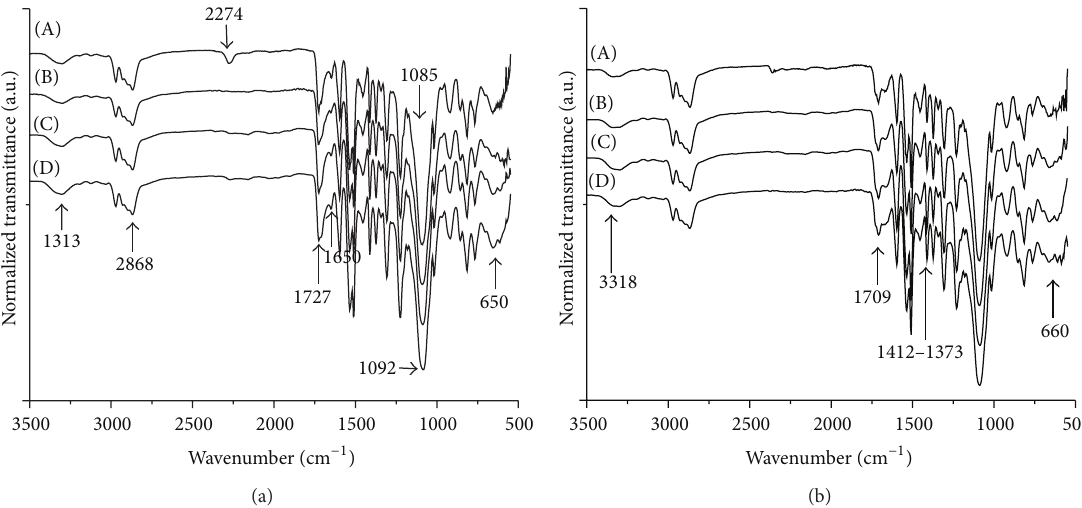
Figure 11: IR normalized spectra of membranes after the removal process; (a) for MPKAl membranes: (A) before removal process, (B) pH 5.7, (C) pH 2.5, and (D) pH 1.5. (b) for TPKAc membranes: (A) before removal process, (B) at pH 5.7, (C) at pH 2.5, and (D) at pH